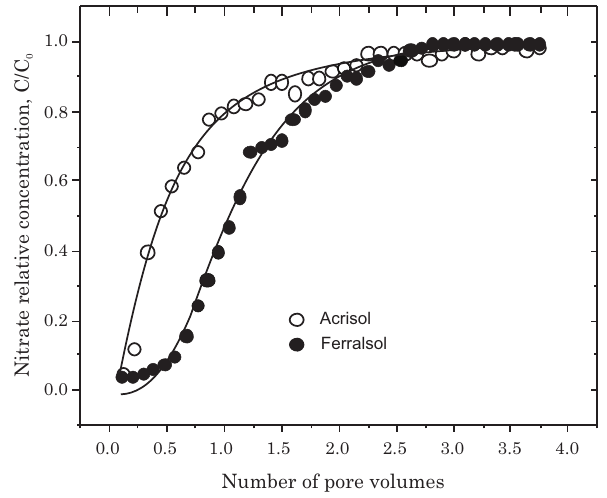
Figure 1. Nitrate breakthrough curves of Acrisol samples from Monte Alegre do Sul (soil 20) and Ferralsol from Guaíra (soil 3).